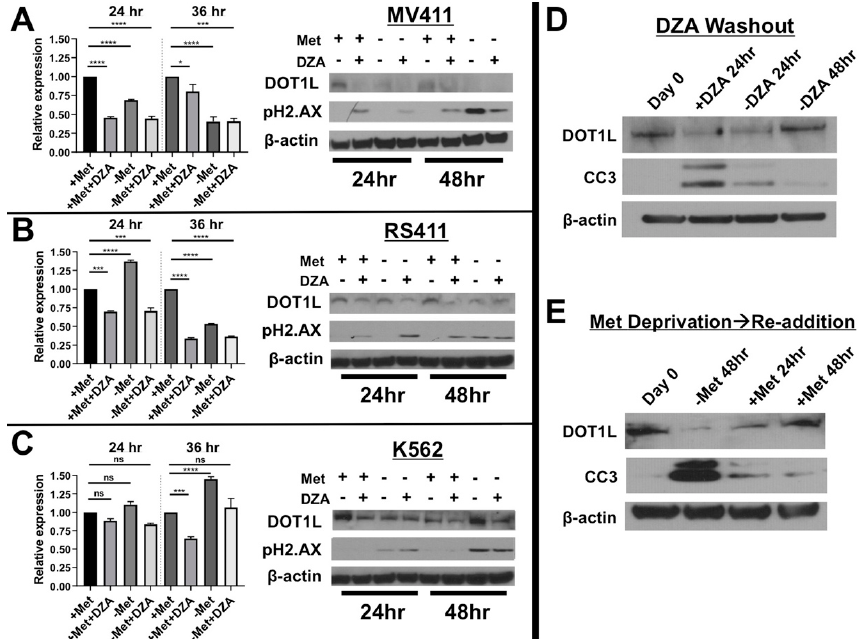
Figure 3. Alteration of Met/SAM metabolism reduces mRNA and protein expression of the required H3K79 methyltransferase DOT1L selectively in MLL-R leukemia cells. (A) DZA treatment or methionine deprivation of MV411 cells significantly reduced DOT1L mRNA (Tukey HSD, * = p <